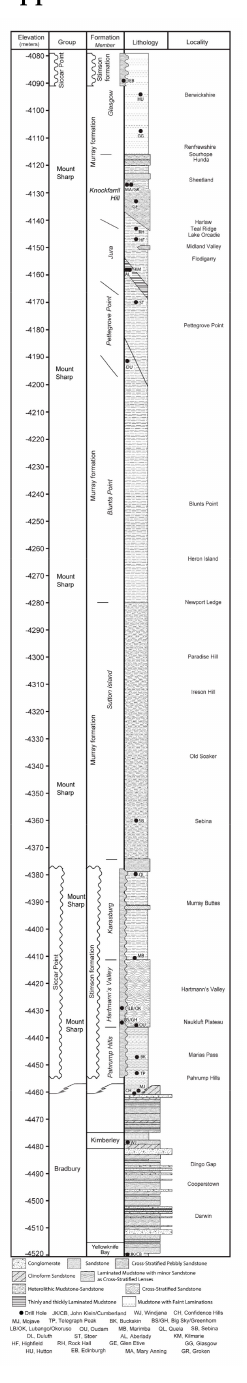
Figure A1. Detailed stratigraphic column of the sedimentary rocks at Gale crater from the MSL sedimentary and stratigraphy working group. The stratigraphic column reflects the units and formations investigated by Curiosity from the landing site near Yellowknife Bay through the Murray formation, Glasgow